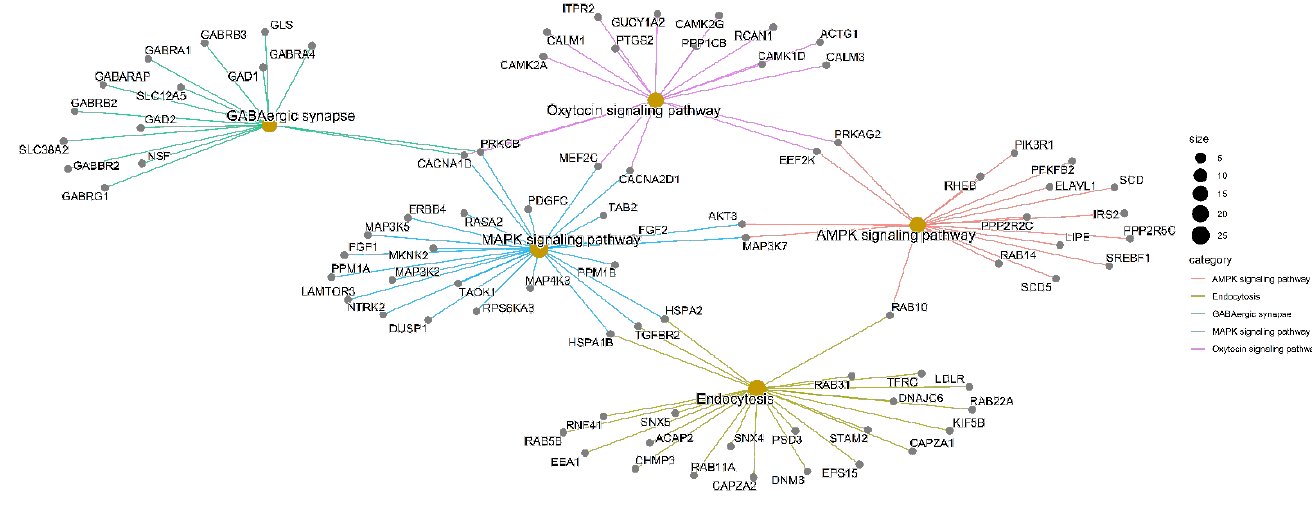
Figure 2. Gene-concept networks from the KEGG enrichment analysis; the beige circles represent pathways while the gray ovals indicate genes.